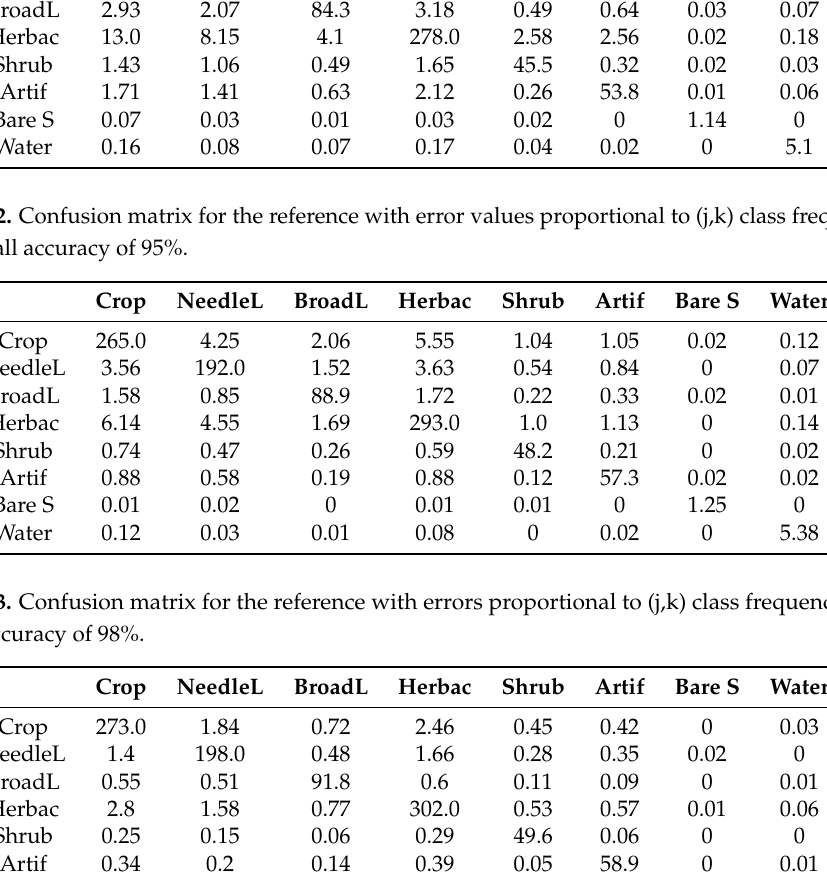
Table A11. Confusion matrix for the reference with error values proportional to (j,k) class frequencies and overall accuracy of 90%. Crop NeedleL BroadL Herbac Shrub Artif Bare S Water Crop NeedleL